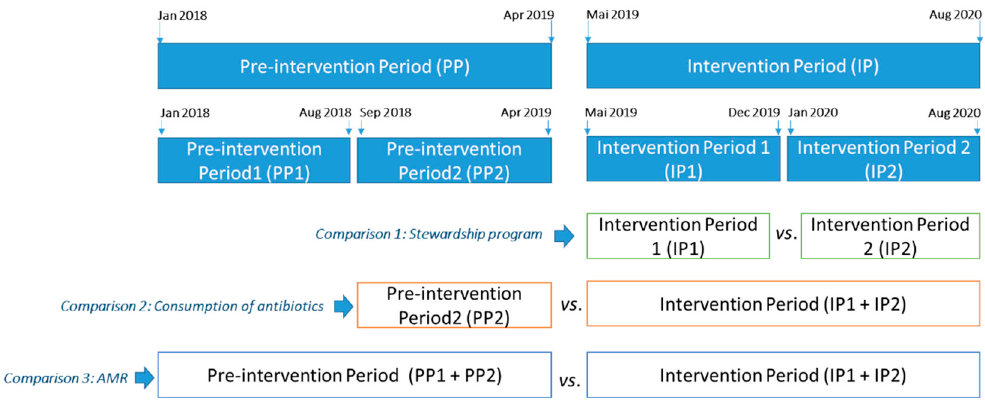
Figure 6. Timeline of the study.